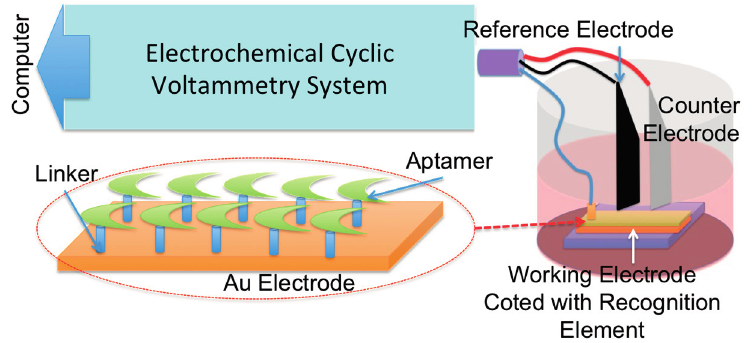
Figure 1. Illustration of an apta-sensor using the electrochemical reading